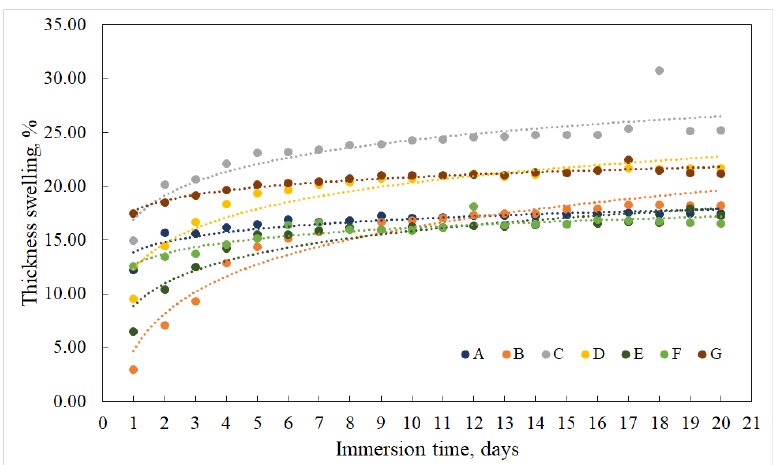
Figure 2. Relationship between immersion time and thickness swelling of particleboard samples with dimensions 5.0 × 5.0 cm for all categories (A–G).